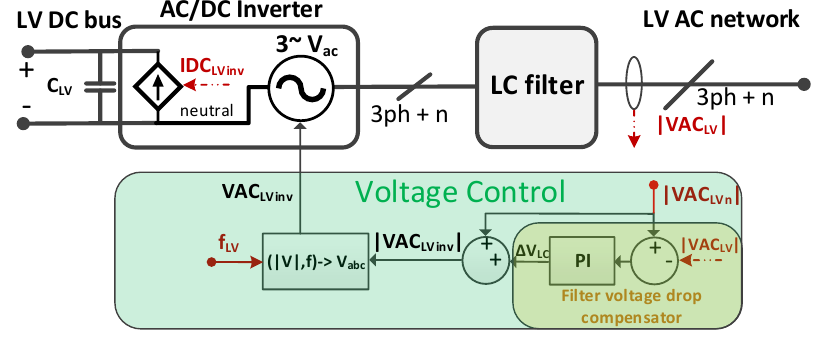
Figure 5. Block diagram of the ST’s Low Voltage